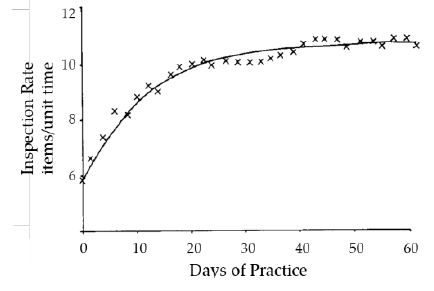
Figure 7. Constant time model graphic [21].